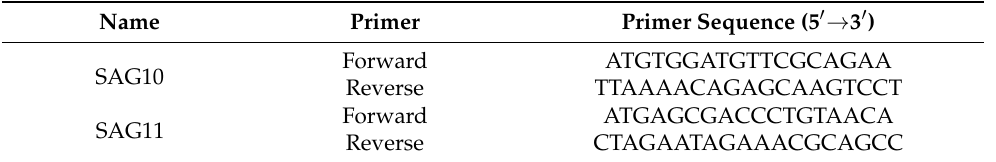
Table 4. Primers of